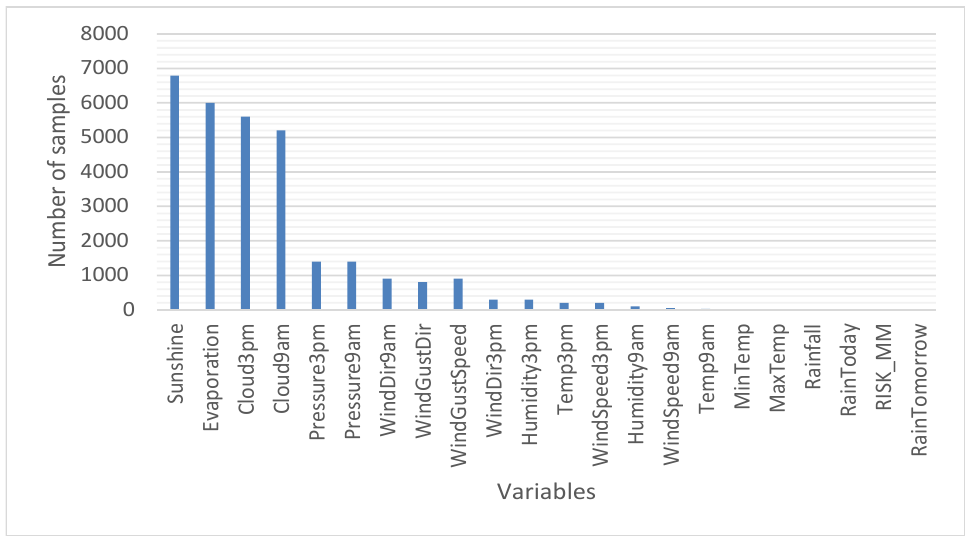
Figure 1. Number of variables with value “NA”.